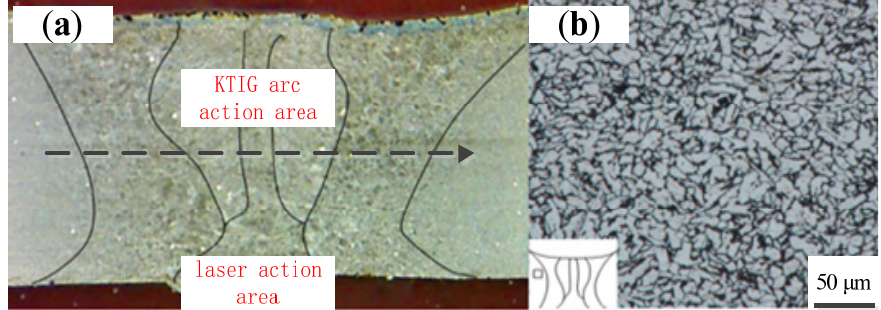
Figure 11. The microstructure distribution: ( a ) laser K-TIG hybrid weld microstructure, ( b ) the base metal microstructure. metal microstructure.